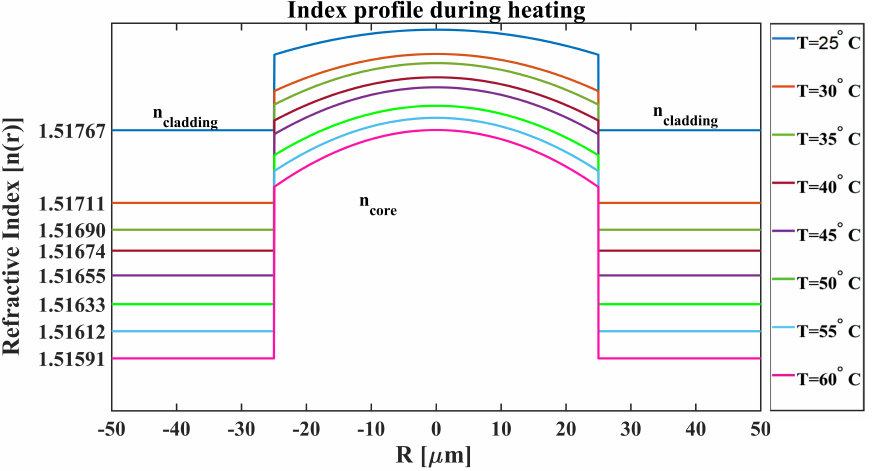
Figure 6. Refractive index distribution of core and cladding of the SWW during the heating process showing a decreasing refractive index with increasing temperature. Moreover, the refractive index difference between core and cladding increases at higher